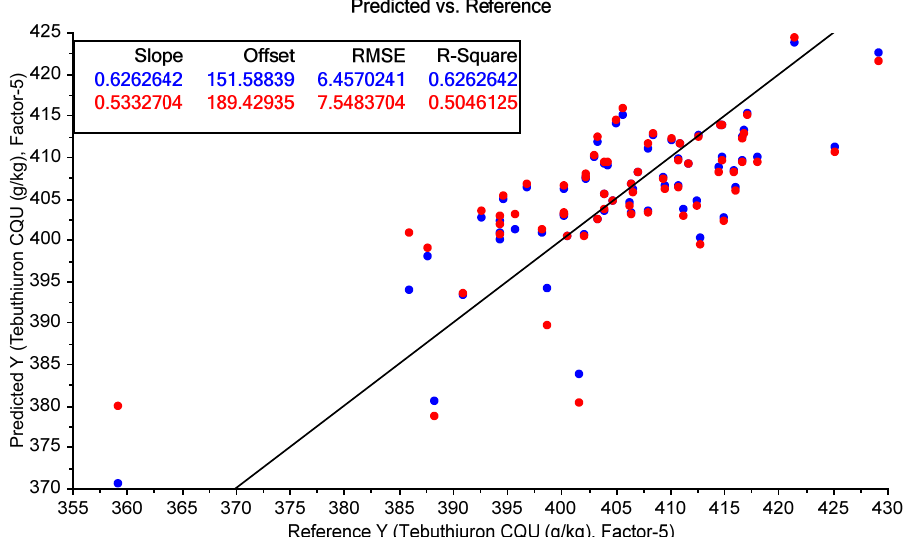
Figure 21. MicroNIR prediction of tebuthiuron content. The blue points show the model calibration, while the red points show the model cross-validation.